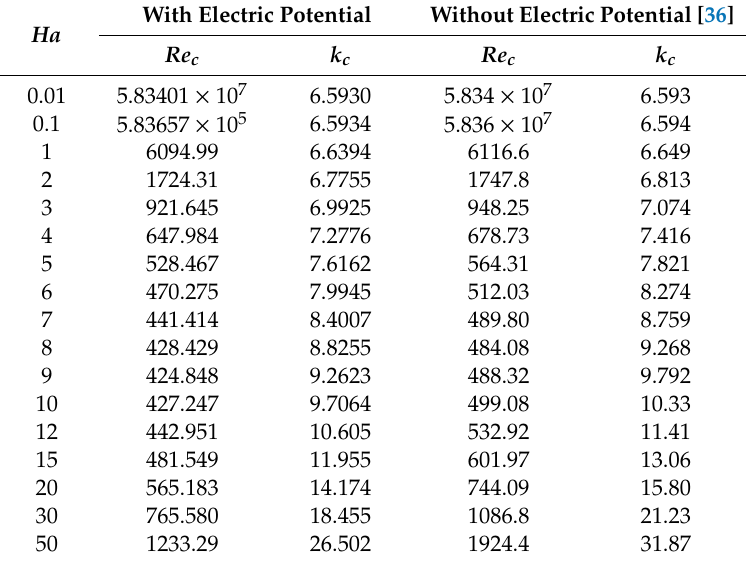
Table 2. The critical Reynolds number and the corresponding wavenumber for the various Hartmann numbers with and without taking the electric potential into account at m = 1. With Electric Ha